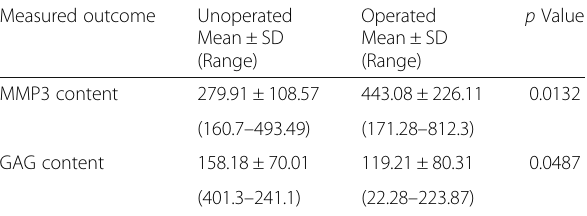
Table 1 Unoperated and operated mean values and standard deviations of MMP-3 protein and GAG content in the synovial fluid Measured outcome